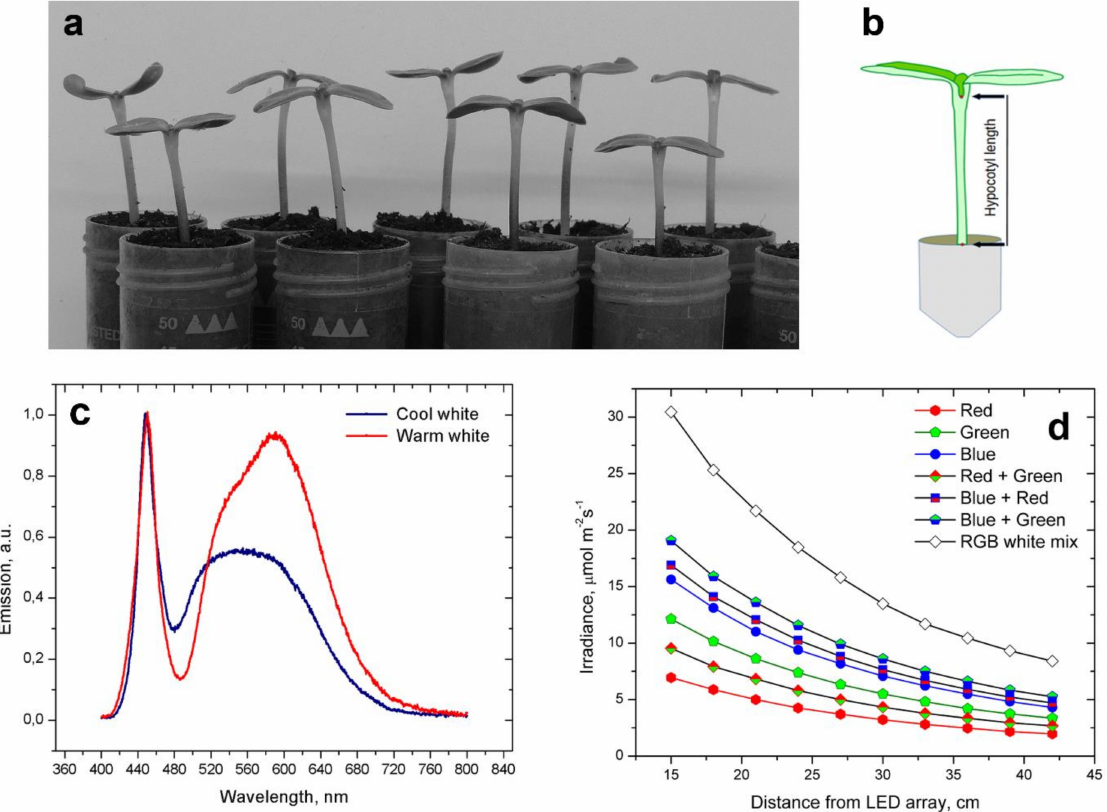
Figure 1. Plant material, measurements of hypocotyl length, and spectral light characteristics of some light sources. ( a ) Plants growing in a diurnal 14/10 h light/dark photoperiod on the sixth day from the onset of germination. ( b ) Schematic diagram of a plantlet showing how relative hypocotyl length was measured. ( c ) Emission spectra of cool-white and warm-white LED panels measured with the Ocean UV NIR 2000 spectrophotometer. Both LED panels had a low emission of far-red light above 700 nm. ( d ) Irradiance in various single, dual, or triple monochromatic light waveband combinations produced by a densely packed array of RGB LED strips (V-Tac, SKU 2124). Irradiance measured with LiCor 250 with a quantum